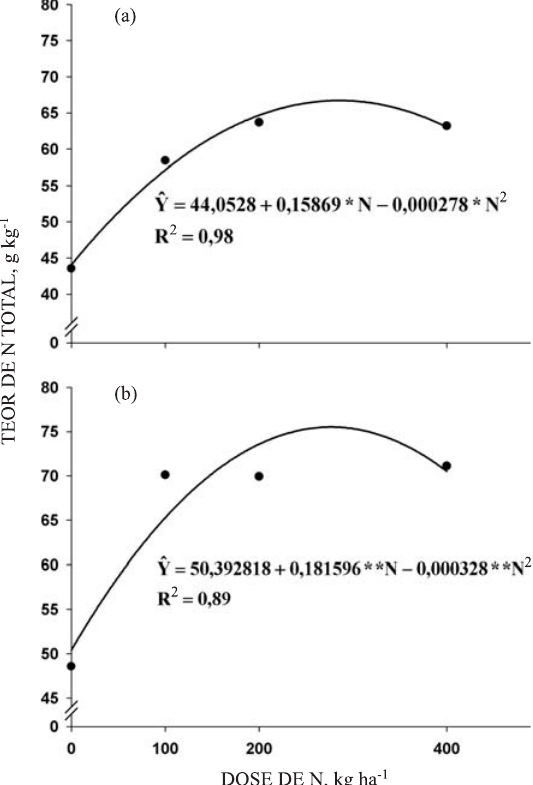
Figura 2. Teor de N-total medido na quarta folha a partir do ápice da batateira aos 21 DAE para as cultivares Ágata (a) e Asterix (b), em função das doses de nitrogênio. **, * e °: significativo a 1, 5 e 10%, respectivamente, pelo teste